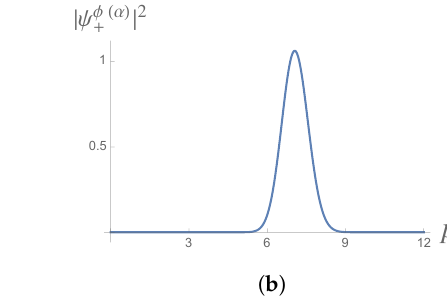
Figure 3. Reduced probability distributions coming from the same physical state (defined through (20) and (46) and here n = 100), but described relative to the choices of ( a ) φ and ( b ) α as internal times in the ‘expanding-forward’ (green) quadrant of Figure 1. Recall that in the reduced theory the usual modulus square of the wave function is the probability distribution, see (15). Due to the symmetry of the model in α and φ , reduced probability distributions will always behave symmetrically.